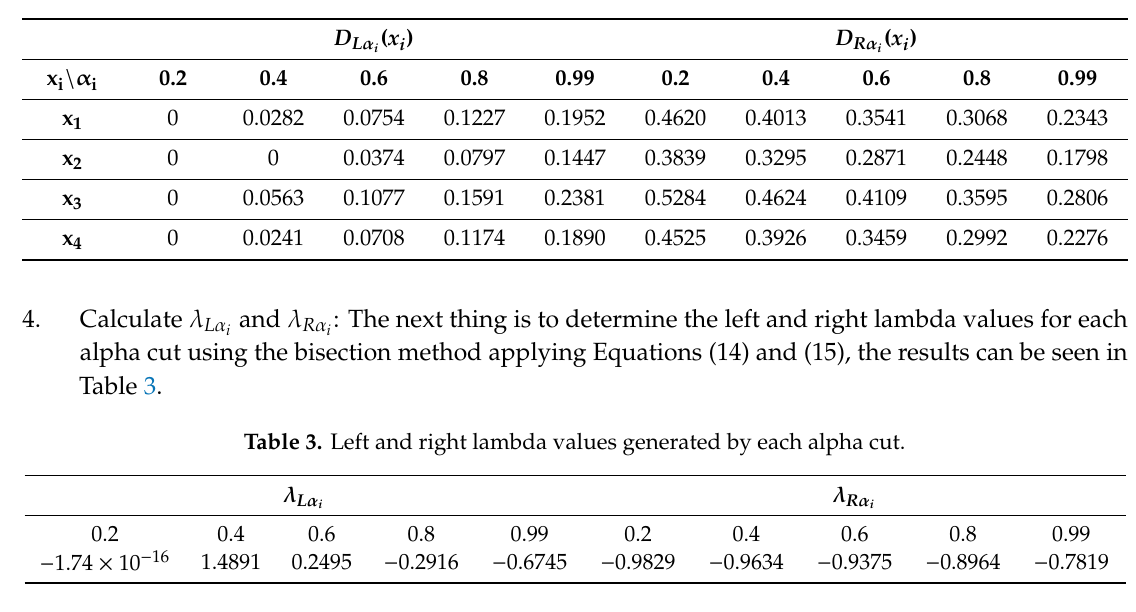
Table 2. Gradients generated by each alpha cut.